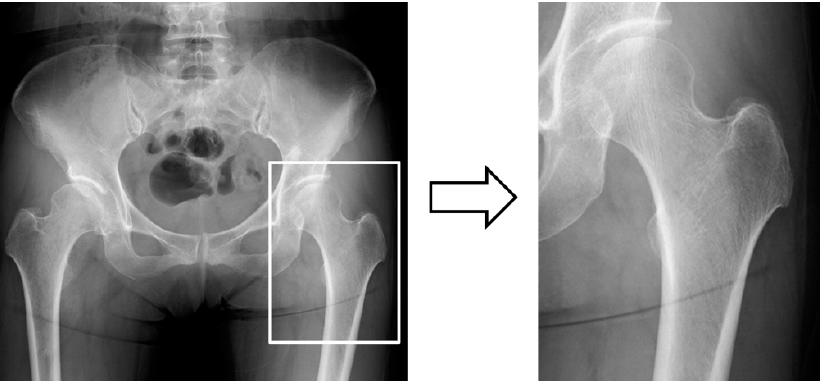
Figure 1. Crop method as data preprocessing. The manually cropped area perfectly imitated the osteoporosis identification range obtained using the dual-energy X-ray absorptiometry (DXA) method.